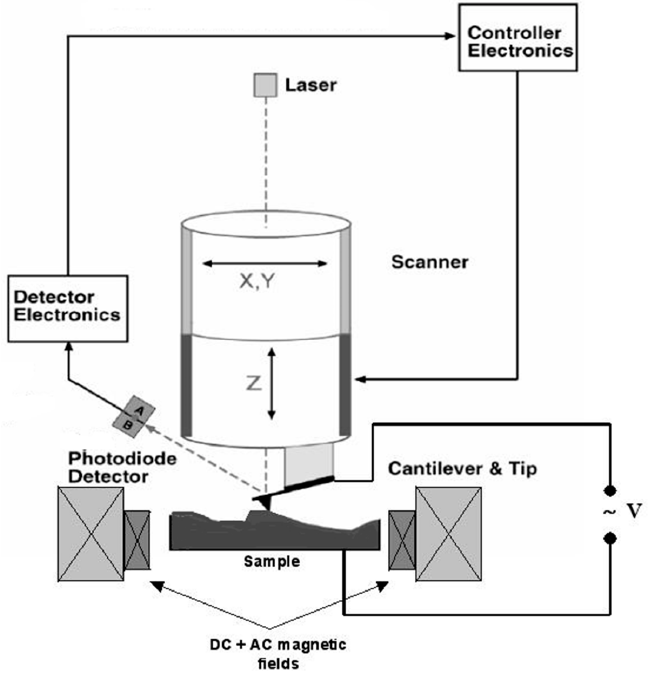
Figure 5. Schematic diagram of a scanning probe microscope adapted to perform multiferroic coupling measurements.